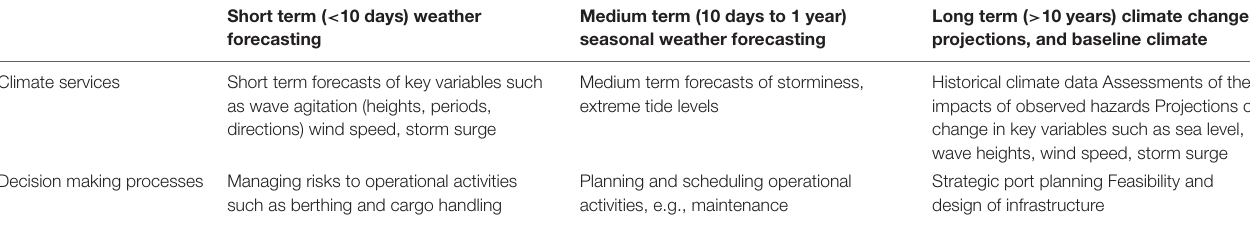
TABLE 1 | Types of climate services and decision-making processes potentially supported (after Lumbroso and Woodhouse, 2014). Short term ( < 10 days) weather